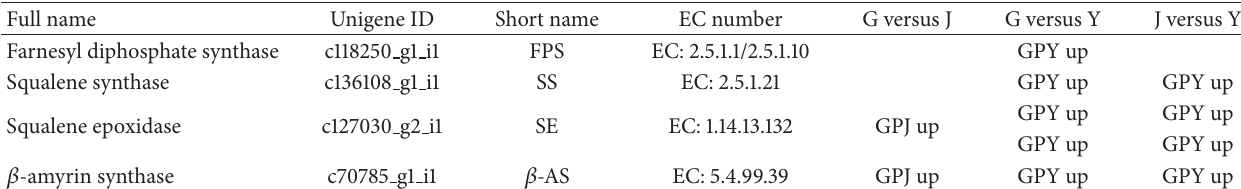
Table 6: Enzyme expression of FPS, SS, SE, and 𝛽 -AS.